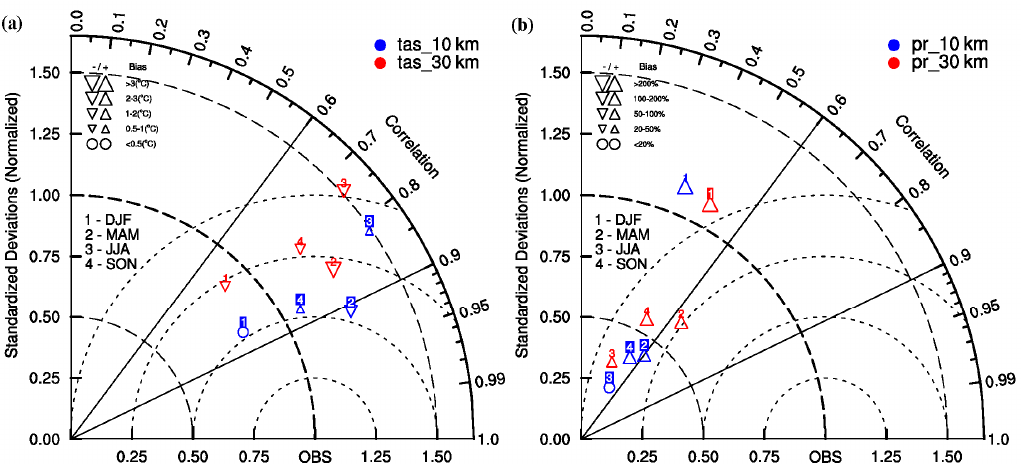
Figure 4. Taylor diagrams of simulated seasonal mean temperature ( a , left panel ) and precipitation ( b , right panel ) in relation to observation data over the whole TP for the period 1980 − 2010.